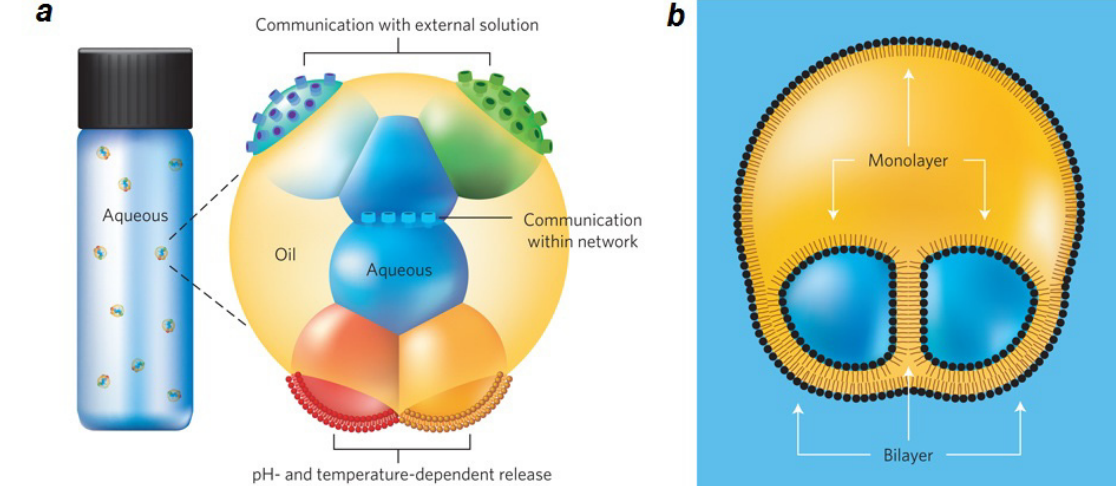
Figure 3. Network of lipid-encapsulated droplets. ( a ) Schematic illustration of a multisome. An oil drop encapsulates aqueous droplets that are connected by lipid bilayers. The bilayer incorporated protein pores allow the droplets in the network to communicate by exchanging molecules and ions. Similarly, pores in bilayers in contact with bulk solution provide routes for exchange between the droplet network and the bulk. Droplet content release can be triggered by pH- or temperature-induced rupture of the bilayers; ( b ) Schematic of an encapsulated two-droplet network, showing the lipid monolayers and bilayers. ( c – e ) Images of the multisomes containing one ( c ), two ( d ) and three ( e ) inner droplets. Oil drops were suspended on wire loops to allow extended analysis. Aqueous droplets were dyed with 25 µM sulphorhodamine 101 (red) or fluorescein (green). Scale bars, 400 µm. Figure is adapted from [112] with